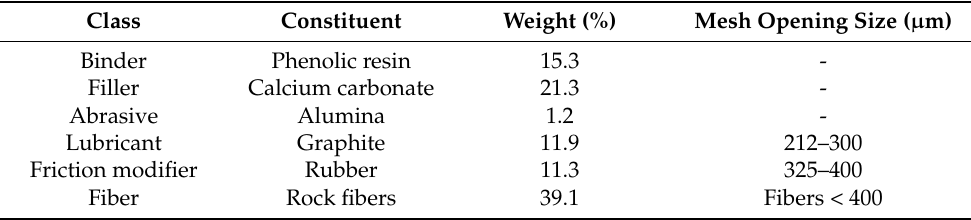
Table 1. Formulation and constituent size of simplified materials.